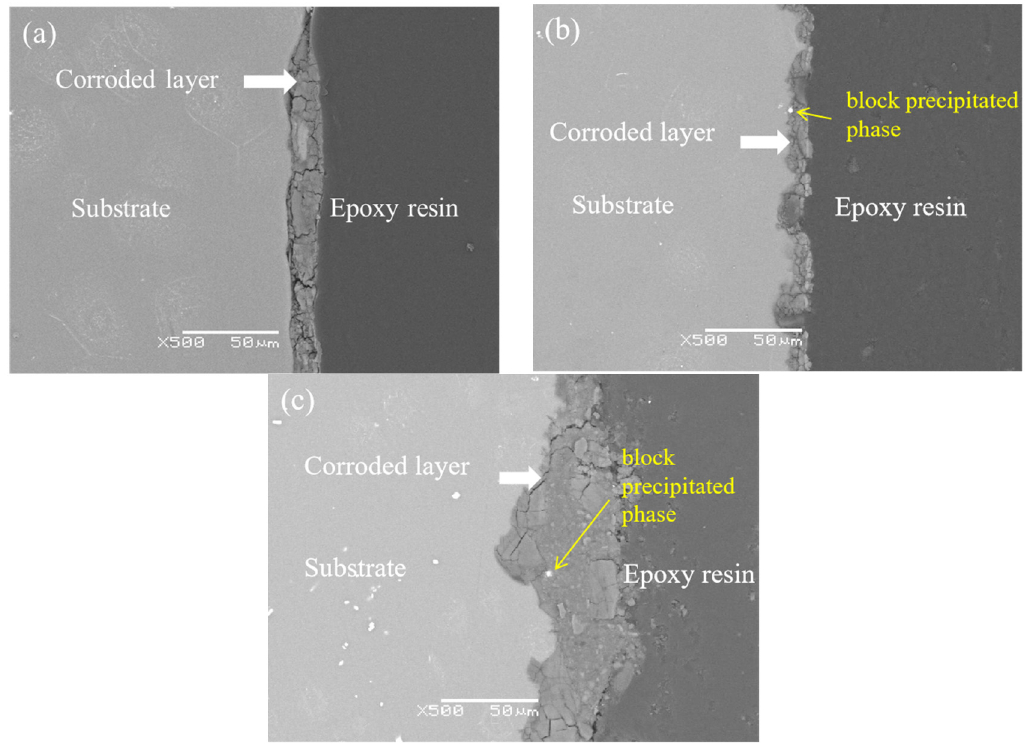
Figure 7. Cross-section morphologies of the specimens after immersion in SBF for 120 h. ( a ) GZ31K, ( b ) GZ61K, ( c ) GZ91K.